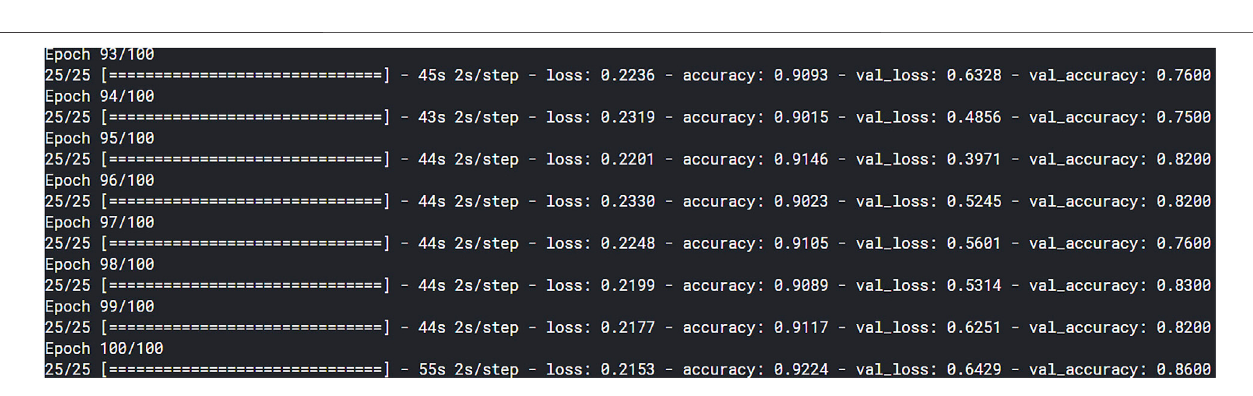
FIGURE 9 | Part of the training results (from epoch 93 to